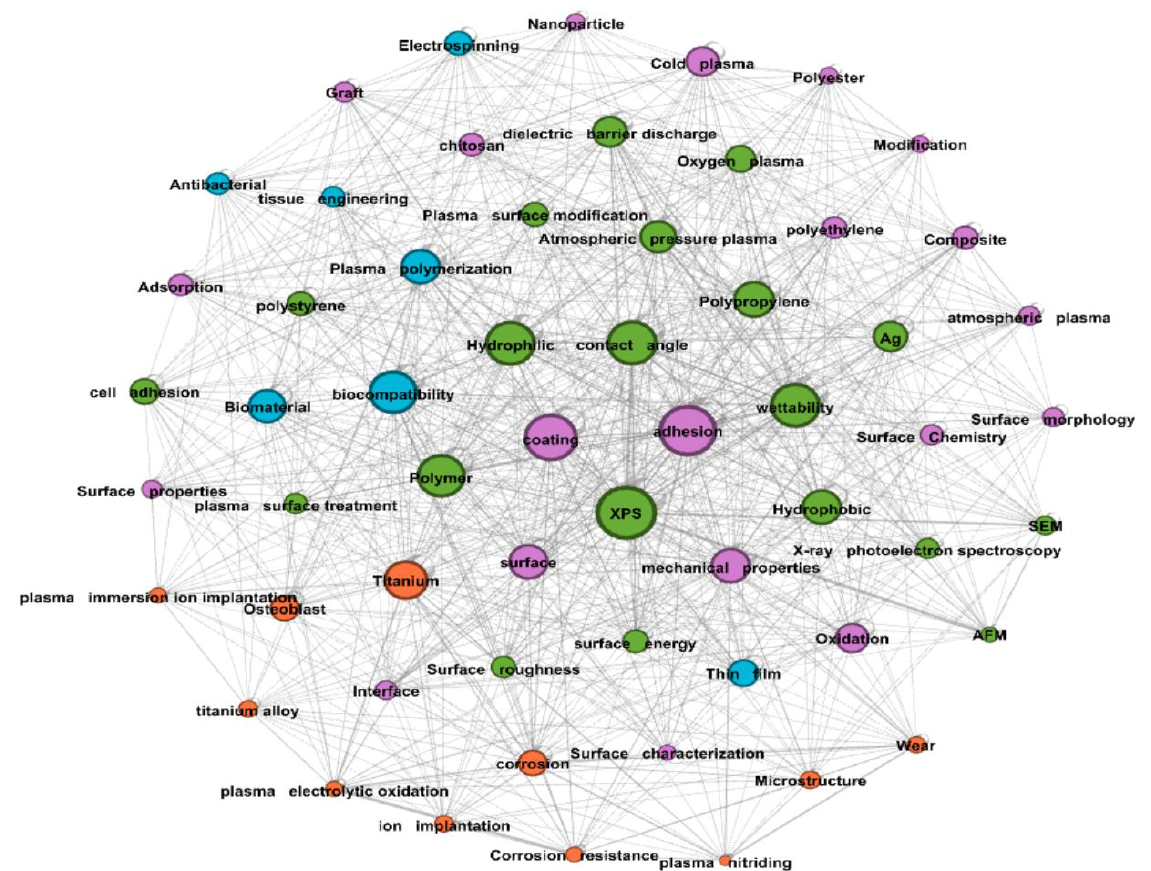
Figure 6. Key author keywords related to plasma surface treatment.